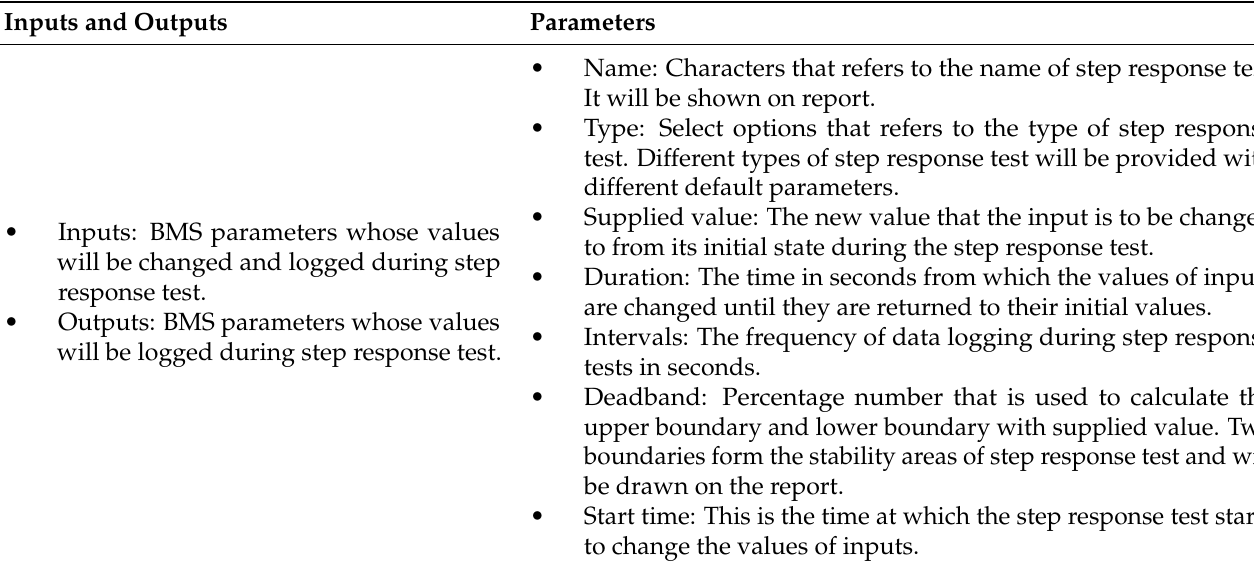
Table 1. Inputs, outputs and parameters used by